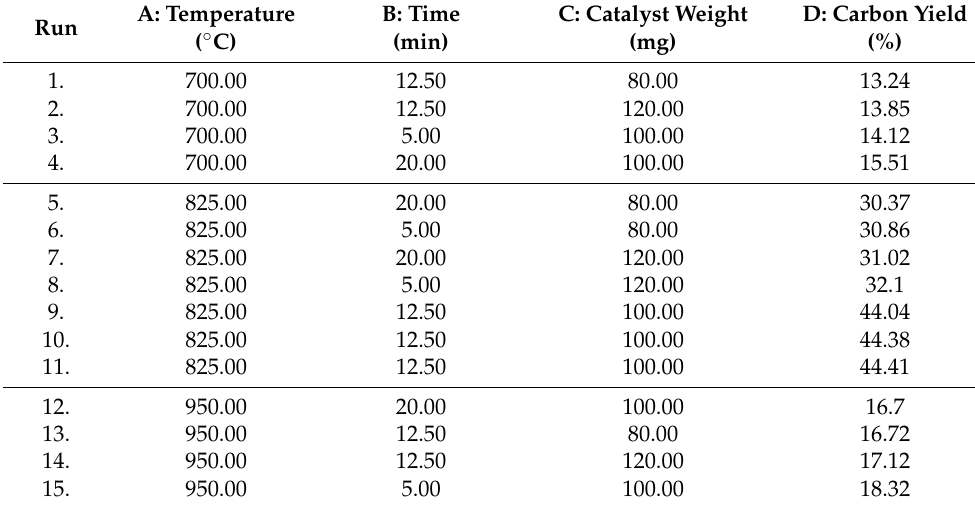
Table 5. Process Parameters optimization for CNT